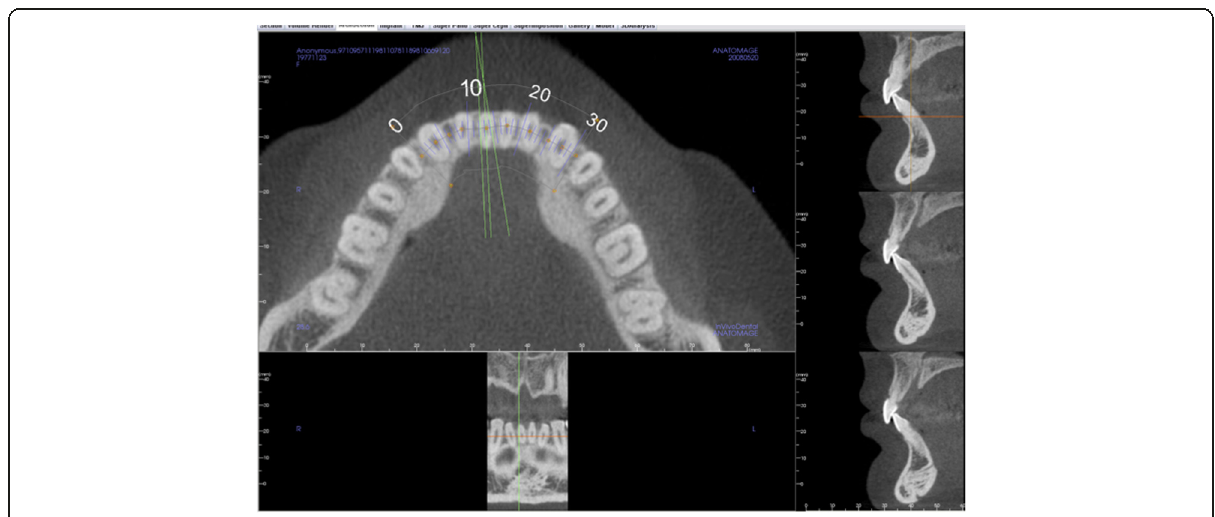
Fig. 1 Horizontal view through the mandibular dentition indicating the location of the sagittal slices to evaluate the alveolar bone and teeth. The slice through the center of the root canal (middle slice on the right) is then used for measurement of the tooth and surrounding bony